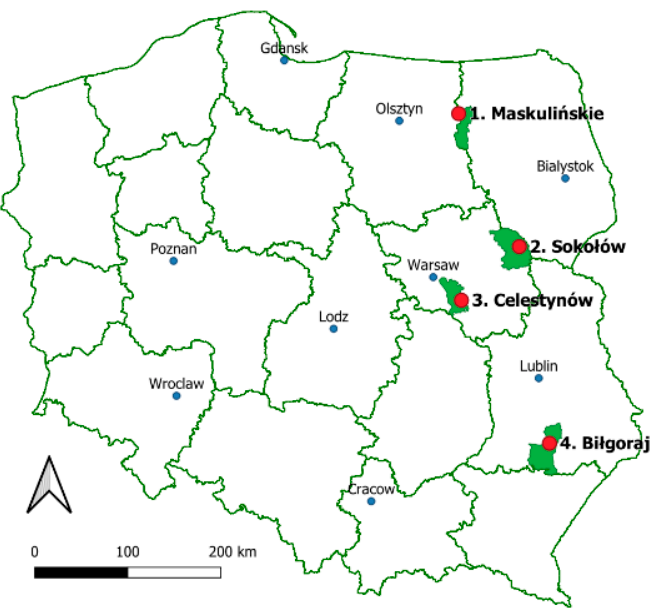
Figure 1. Location of the research plots in the background of forest districts and RDSF.